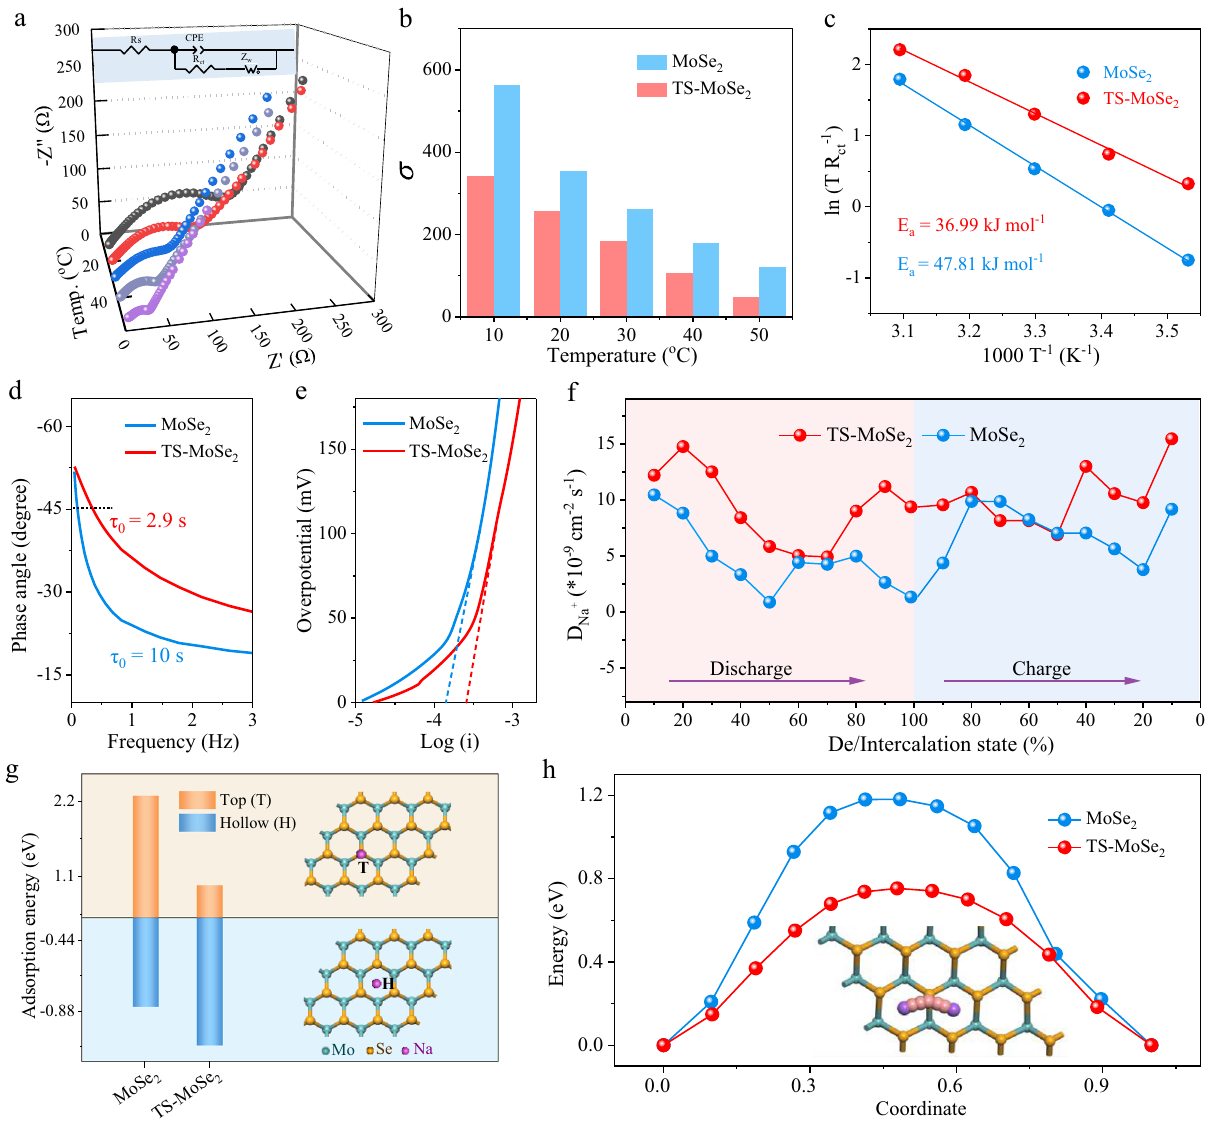
Fig. 6 | Electrochemical kinetics analysis. a EIS spectra of TS-MoSe 2 at different temperatures after 5 cycles. The inset is an equivalent circuit used to simulate EIS spectra. b σ values at different temperatures calculated from EIS curves. c Arrhenius plots of ln (T/R ct ) vs. 1/T in TS-MoSe 2 and MoSe 2 electrodes. d Bode plots of TS-MoSe 2 and MoSe 2 electrodes. e Tafel plots of TS-MoSe 2 and MoSe 2